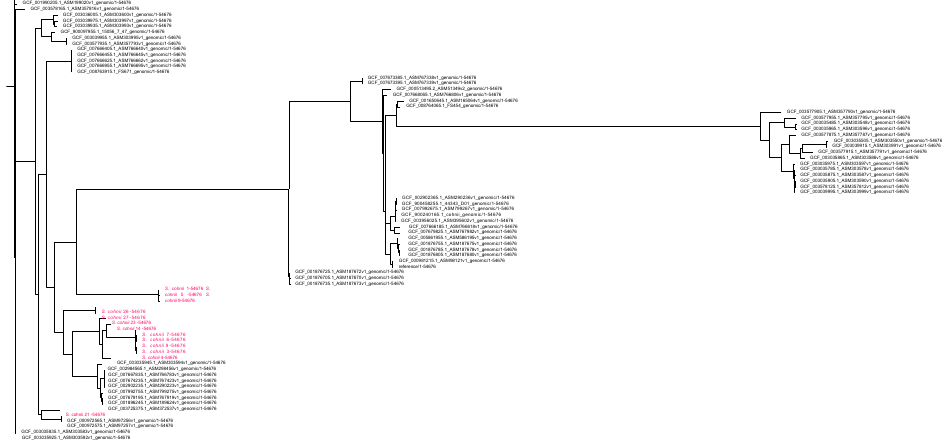
Figure 2. Rooted phylogenies of all sequenced S. cohnii isolates present in NCBI on April 29. 2020.